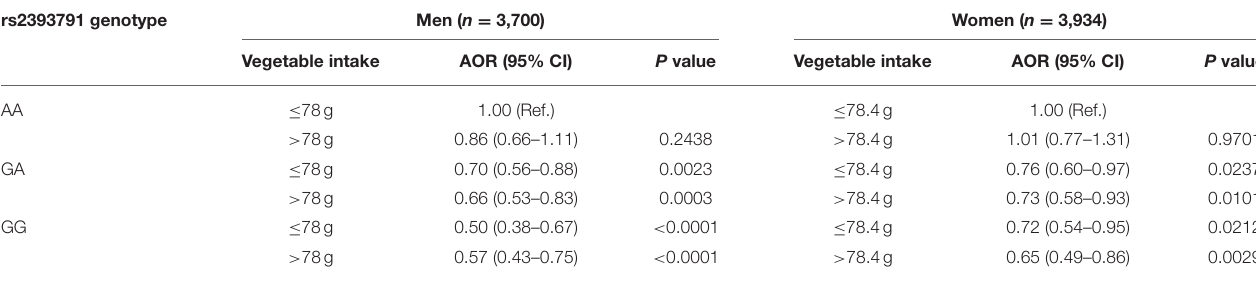
TABLE 5 | Association of HNF1A rs2393791 genotype and vegetable intake with inflammation. rs2393791